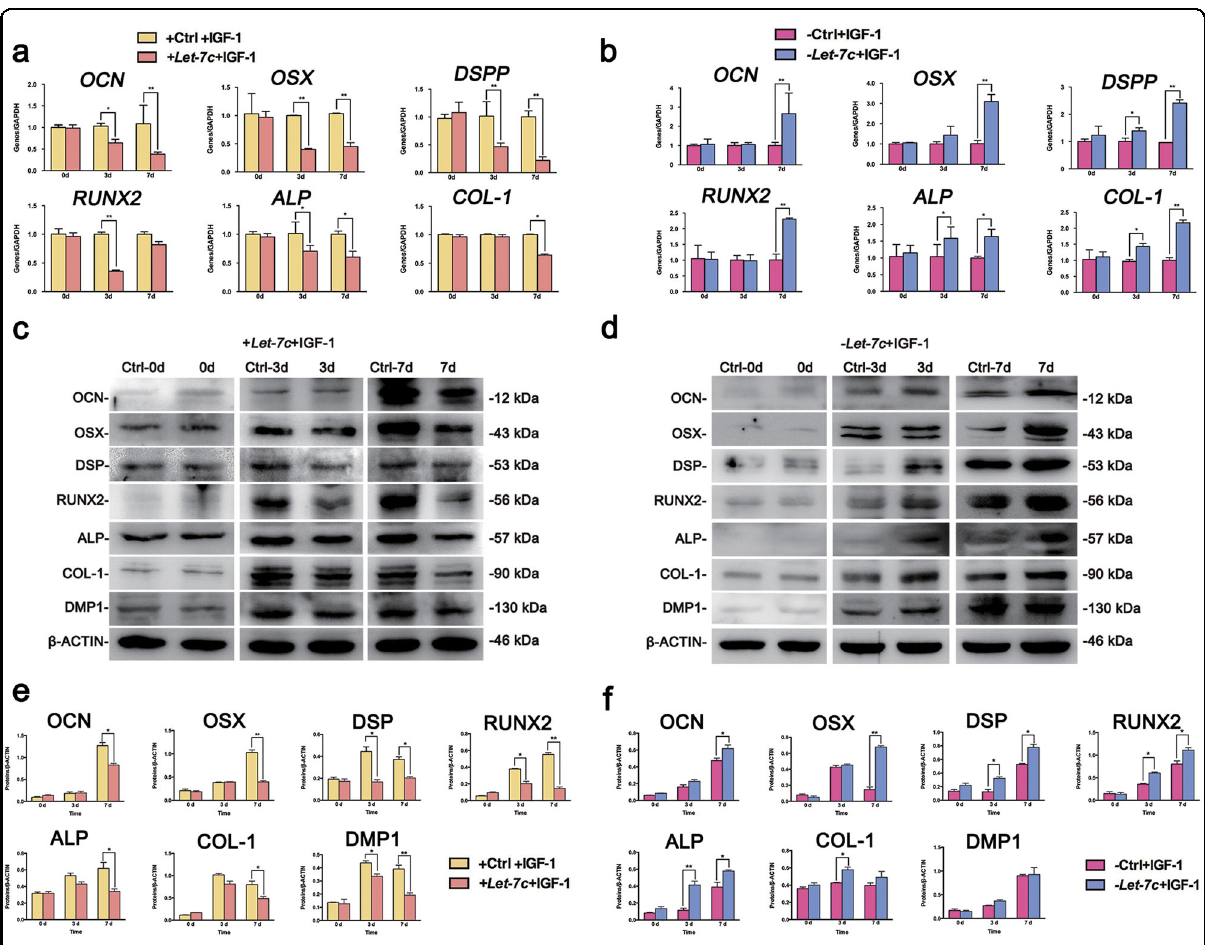
Fig. 4 Effects of let-7c on the odonto/osteogenic differentiation of IGF-1-treated DPMSCs by RT-PCR and Western blot. a The expression levels of odonto/osteogenic genes ( OCN , OSX , DSPP , RUNX2 , ALP , and COL-1 ) were signi fi cantly lower in + Let-7c DPMSCs as compared with + Ctrl DPMSCs in 100 ng/mL IGF-1-treated media. b The expression levels of odonto/osteogenic genes were signi fi cantly higher in − Let-7c DPMSCs than in – Ctrl DPMSCs. Values are presented as the mean ± SD. n = 3. **2 – ΔΔ Ct ≥ 2, P < 0.01; *1 < 2 – ΔΔ Ct < 2, P < 0.01. c Western blot analysis of odonto/ osteogenic proteins (OCN, OSX, DSPP, RUNX2, ALP, COL-1, and DMP1) in + Let-7c and + Ctrl DPMSCs in 100 ng/mL IGF-1-treated media. d Western blot analysis of odonto/osteogenic proteins in – Let-7c and – Ctrl DPMSCs. e Quantitative analysis of c . f Quantitative analysis of d . β -ACTIN served as the internal control. Values are presented as the mean ± SD, n = 3. ** P < 0.01; * P <